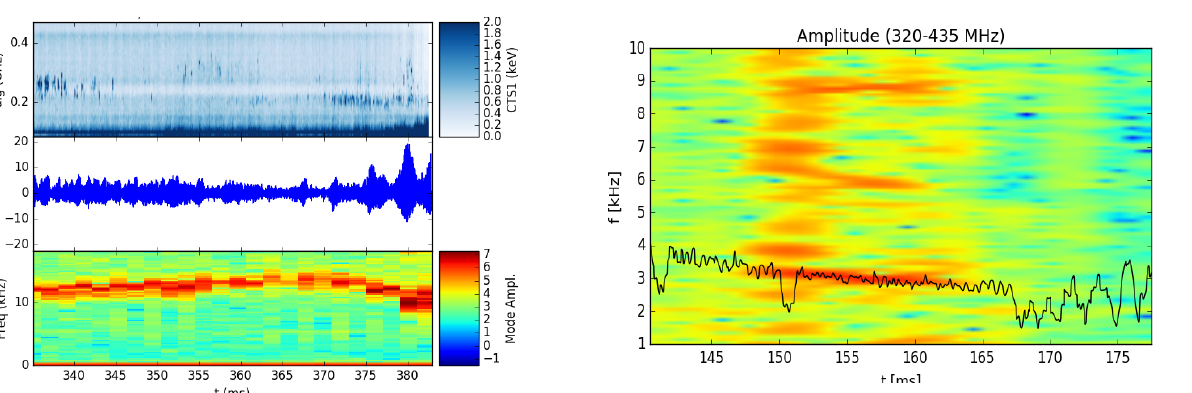
Fig. 5. Top: emissions for shot #40772, showing a variable frequency. Center: Mirnov coil signal, whose frequency spectrum (Bottom) indicates the presence of a m:n=2:1 mode rotating at a frequency above 10 kHz.